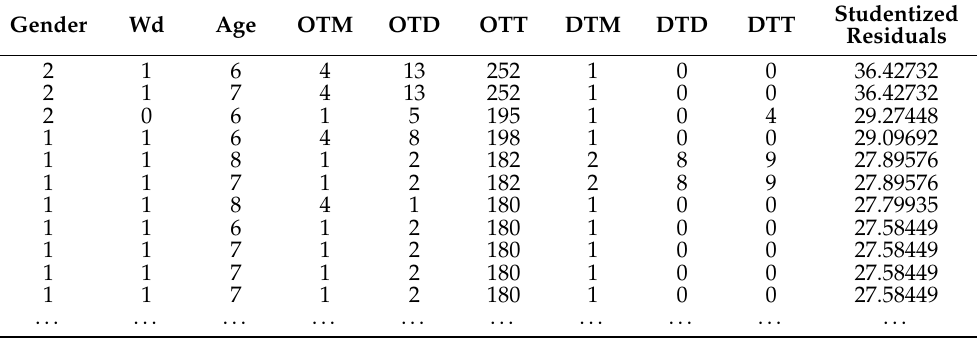
Table 7. Identification of abnormal values based on the variables of origin travel distance and time (May